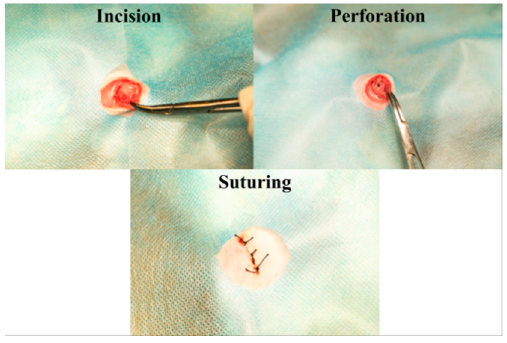
Figure 11. Surgical procedure.